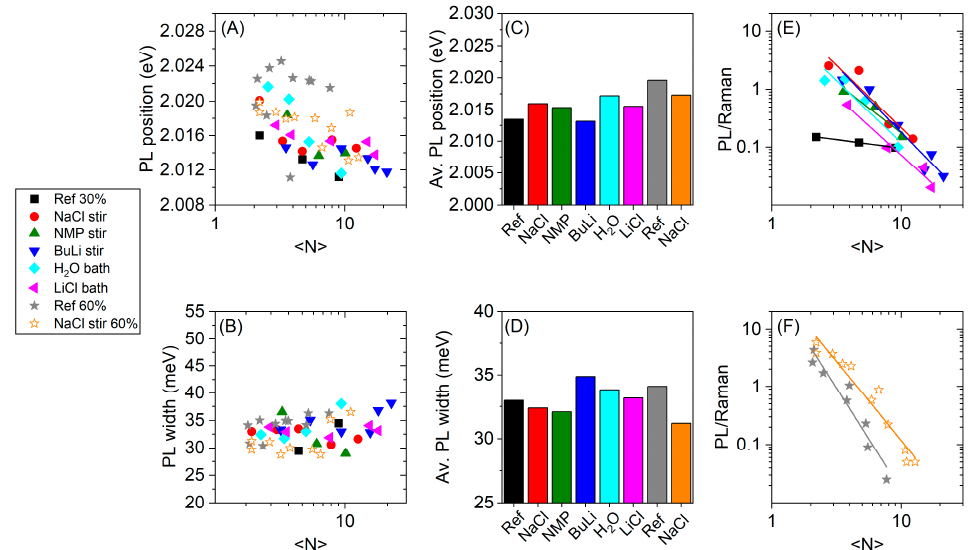
Figure 4. Analysis of the fluorescence data of liquid-phase exfoliated and size-selected WS 2 nanosheets in aqueous dispersion, obtained from the Raman spectra (Figures A3 and A4) and the corresponding fits shown in Figures A5–A12. ( A ) PL position as a function of <N>, ( B ) PL width as a function of <N>, ( C ) Average PL position of the different batches, ( D ) Average PL width of the different batches. In ( C , D ) the PL position and width were averaged over all collected samples of one pretreatment method. ( E ) PL/Raman ratios of the 30% amplitude series as a function of <N>. ( F ) PL/Raman ratios of the 60% amplitude series as a function of <N>. The PL/Raman ratios of the pretreated batches are higher than the